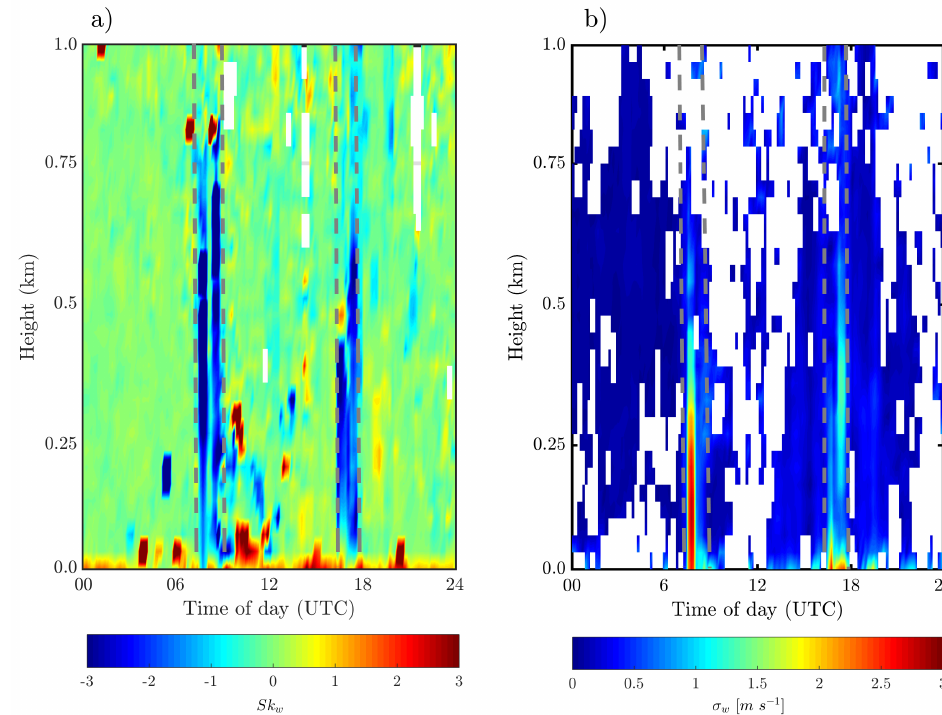
Figure 4. Temporal variation of the vertical profiles of: ( a ) skewness ( Sk w ) and ( b ) standard deviation ( σ w ) of the vertical wind velocity, during 21 April 2014 measured above the T3 site. The gray dashed lines indicate the time of occurrence of the downdrafts coming from the squall